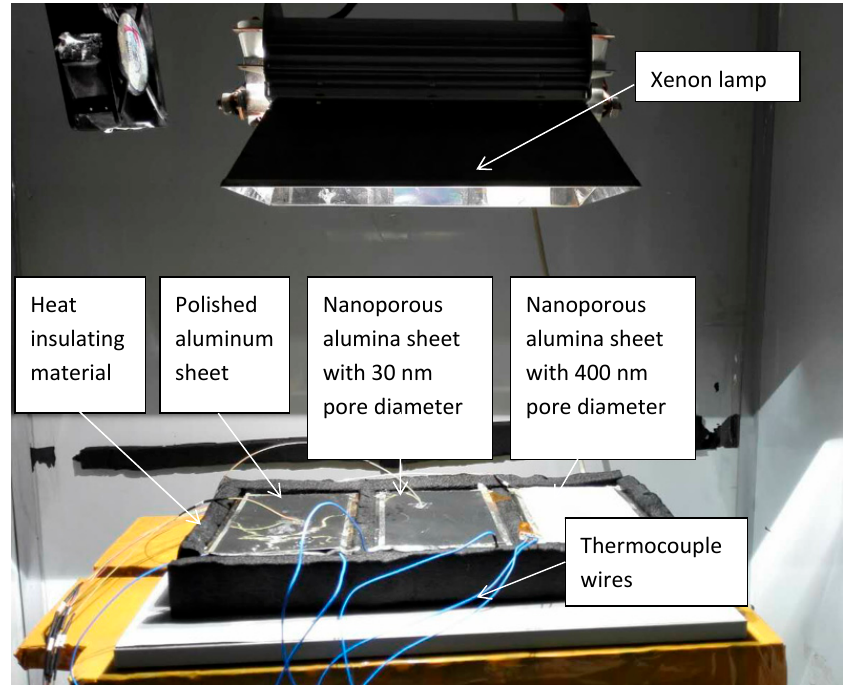
Figure 7. Image of the testing rig.